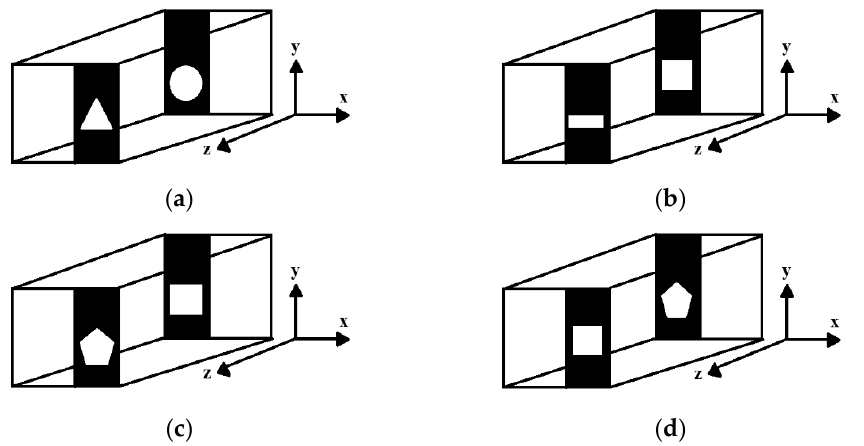
Figure 1. The 3D objects used in the off-axis digital holographic recording geometry: ( a ) circle – triangle ; ( b ) square – rectangle ; ( c ) square – pentagon ; ( d ) pentagon – square. Circle: 2 mm in diameter; triangle: 2 mm in x and y directions; square: 2 mm in x and y directions; pentagon: 2 mm in x and y directions; rectangle: 2 mm in x direction and 1 mm in y direction. The distance between the first plane and second plane was 8 mm in the z direction.